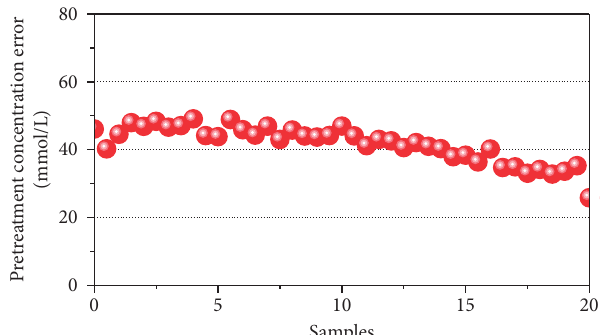
Figure 8: Concentration error plot after rough set